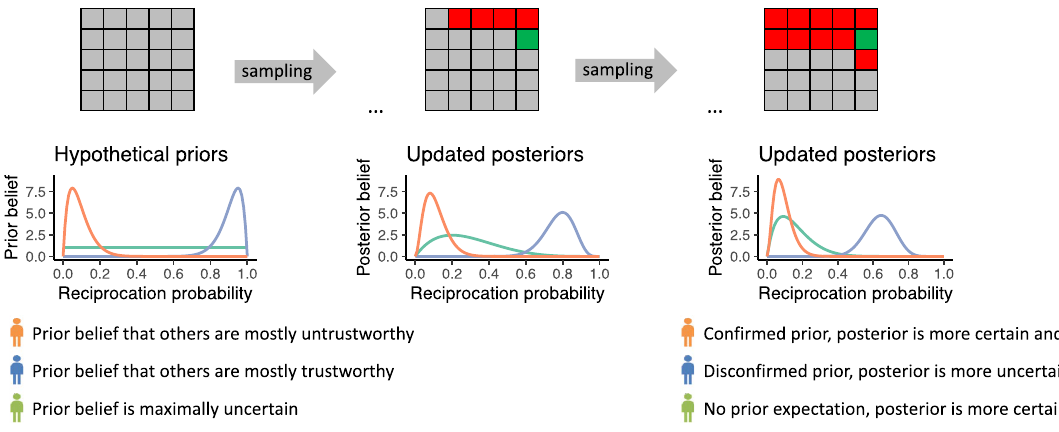
Figure 1. Illustration of how prior belief distributions update to posterior beliefs. The grid represents sampled information about trustworthiness. A green tile indicates that the sample resulted in an observation of trustworthiness, red tiles represent observations of untrustworthiness, and grey tiles are not sampled. At the start all tiles are grey as no samples have been drawn yet and therefore the current belief distribution about trustworthiness is the prior belief distribution. The belief distributions update with each sample. The orange, green and blue lines in the plots represent three hypothetical subjects’ prior belief distributions and their corresponding, updated posterior belief distribution. The updated posteriors belief distributions in the middle reflect an intermediate belief stage when there are 4 red and 1 green tile. The updated posterior belief distributions on the right reflect the scenario where even more samples were drawn (10 red and 1 green tile). These three hypothetical subjects were selected to illustrate that the posterior beliefs can be quite